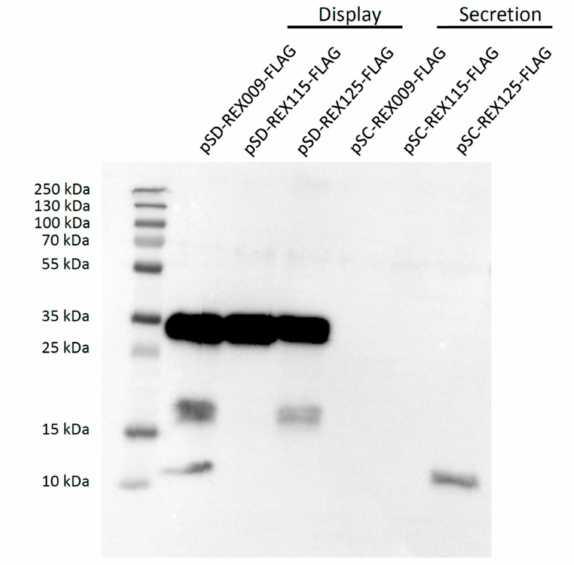
Figure 3. Western blot of 10-fold concentrated conditioned media of L. lactis cultures expressing FLAG-tagged REX